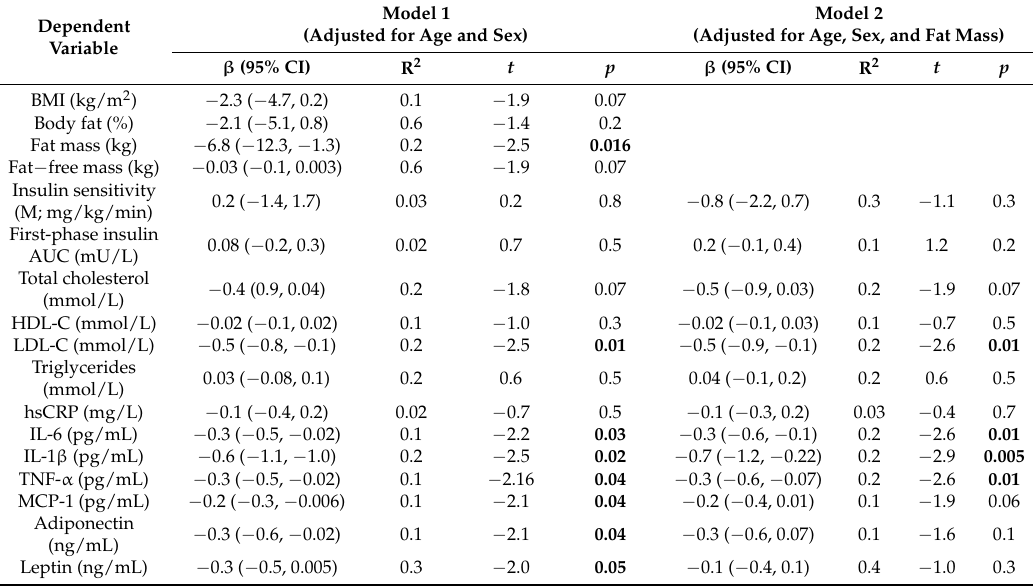
Table 2. Multivariable linear regression models examining associations between cardiometabolic parameters and AMY1 CNV groups after adjustment for